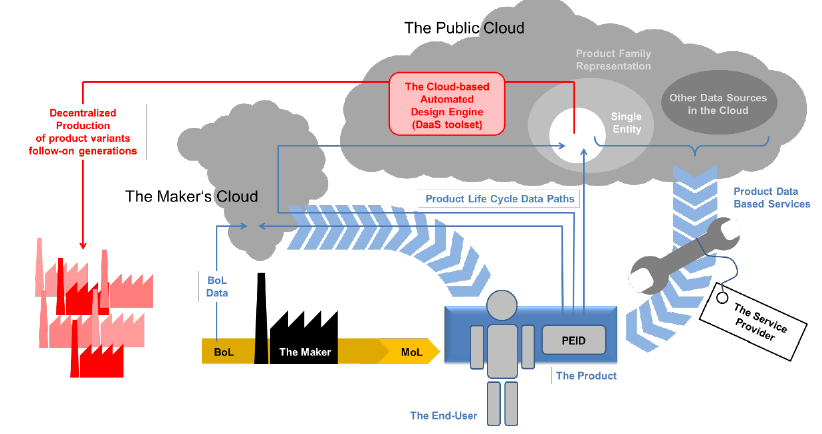
Figure 14. An overview of data flows between stakeholders integrating the cloud and highlighting possibilities of cloud-based product-related services.